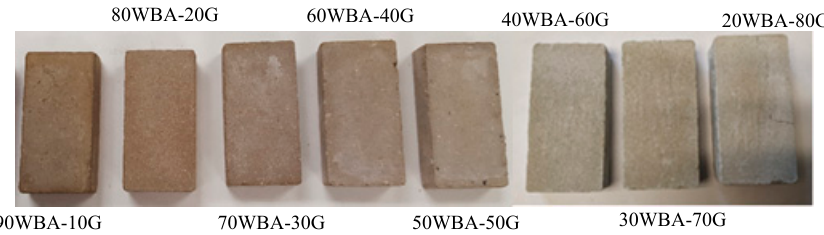
Figure 5. Calcium silicate units.